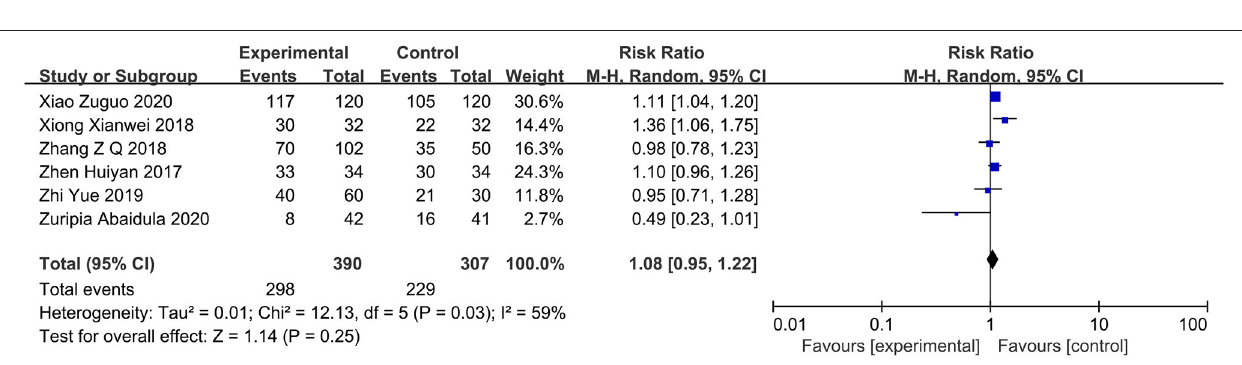
FIGURE 3 | Forest plot of the case fatality rate between the PPI treatment group and the conventional treatment group. PPI, proton-pump inhibitor.